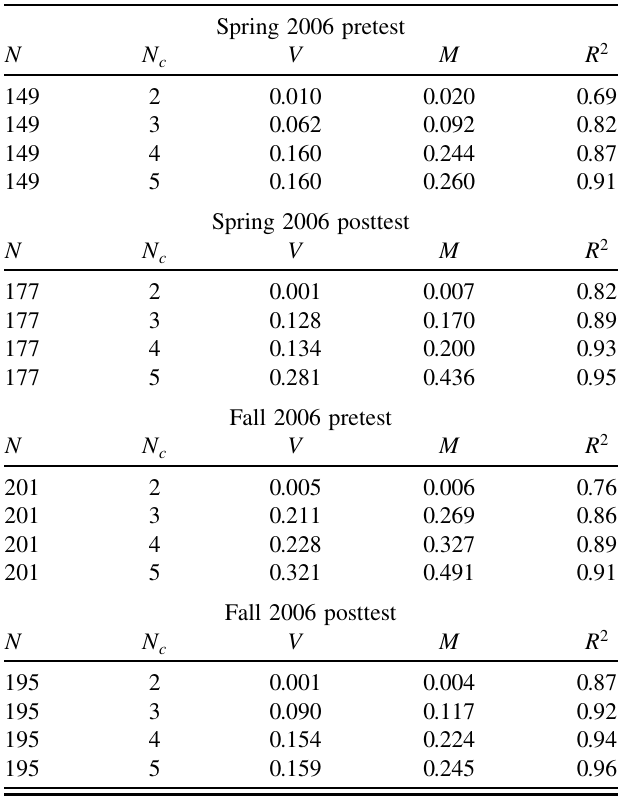
TABLE II. Clustering of pretest and posttest data. N is the the number of clusters, V the maximum number of students, N c pairwise overlap of the probability vectors, and M the predicted misassignment